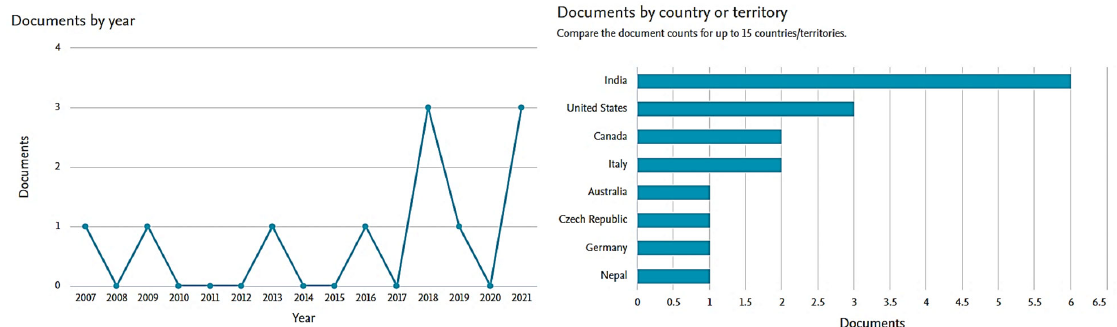
Fig. 5. Analysis and evolution of the words “brick”, “re- duces”, “air” and “pollution”. Source: Scopus scientific review.